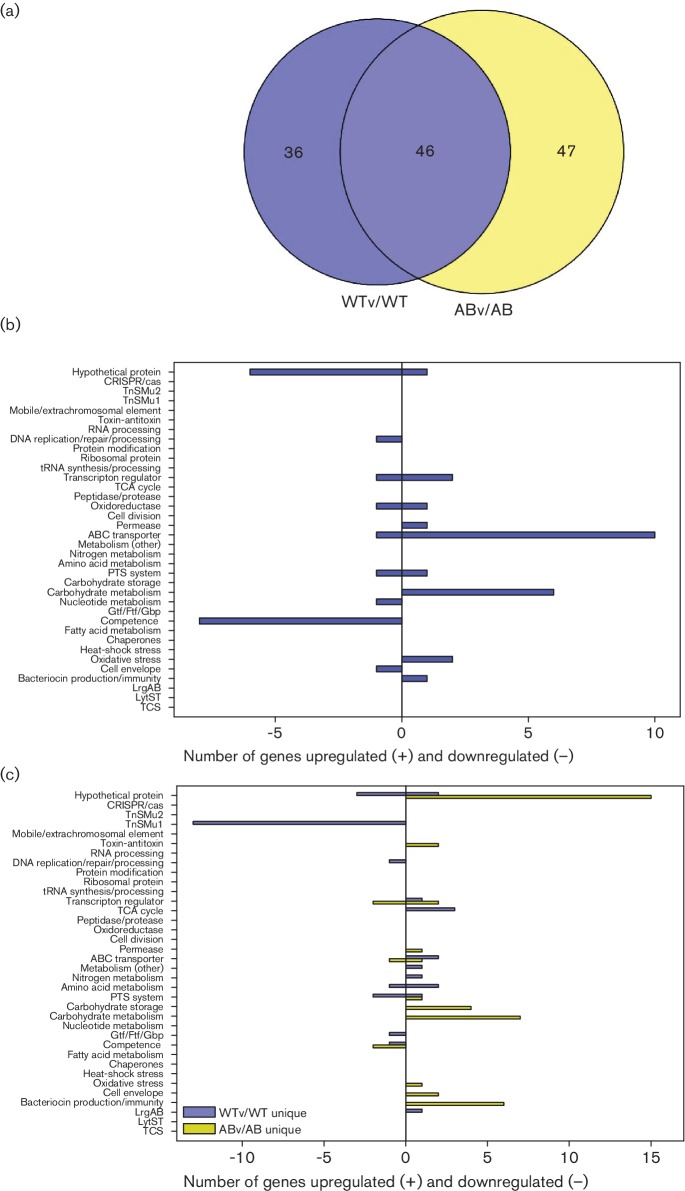
Comparison of wild-type and lrgAB mutant gene expression during vancomycin growth. (a) Venn diagrams were used to identify overlapping and unique genes in WTv/WT and ABv/AB DE analyses (≥1.5-fold change and P<0.005). (b) Functional categorization of overlapping genes between WTv/WT and ABv/AB DE analyses (≥1.5-fold change and P<0.005). (c) Functional categorization of 12 and 15 genes unique to WTv/WT (blue bars) and ABv/AB (yellow bars) DE analyses, respectively (≥1.5-fold change and P<0.005). For (b) and (c), functional categories were assigned using genomic functional annotations as well as those found in the DAVID and PATRIC databases. Upregulated genes in each category are found to the right of the y-axis (positive numbers), and downregulated genes are found to the left of the y-axis (negative numbers).